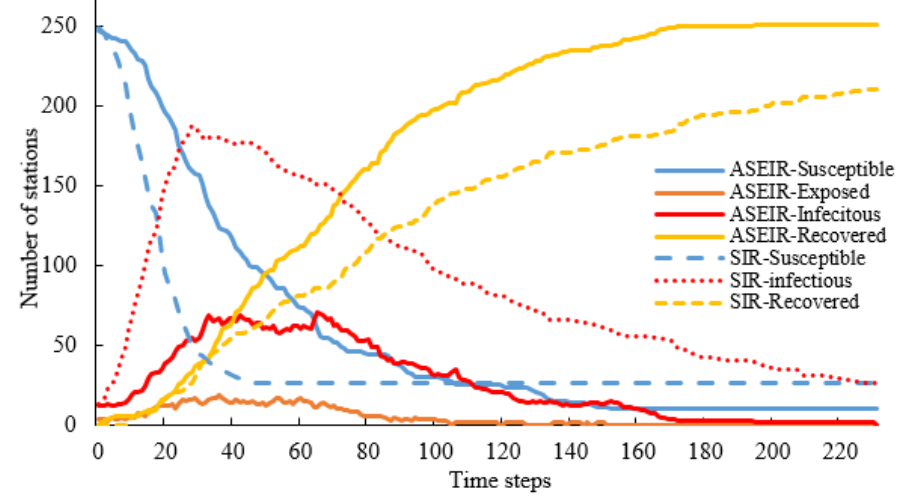
Figure 8. Simulation results of the SIR model and the ASEIR model.